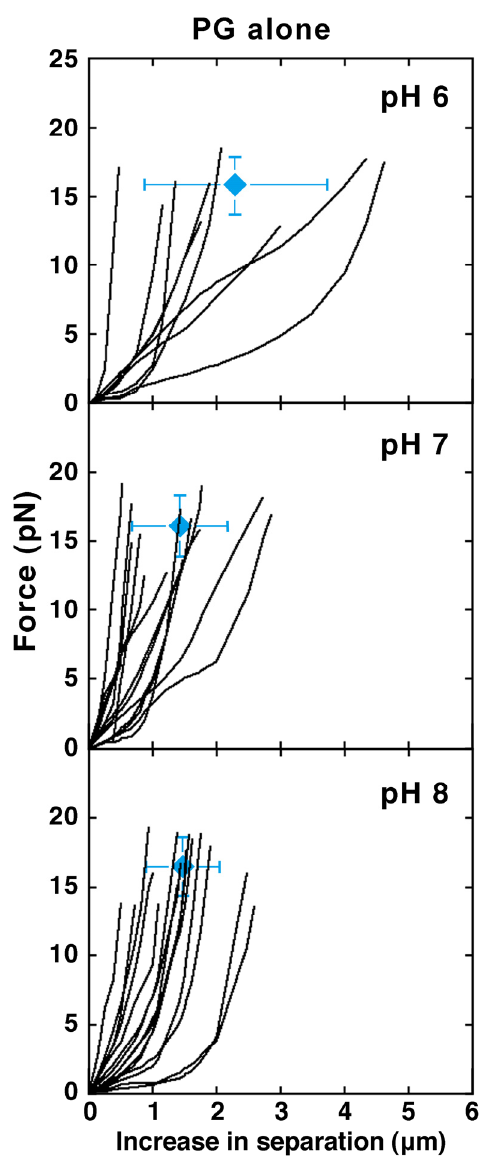
Figure 4. Liposomes made from PG alone under different pH conditions. Top, middle and bottom show the results for pH 6, 7 and 8, respectively. In each panel, the average and S.D. of the ending positions of plots is indicated (N is 9 (pH 6), 13 (pH 7) and 15 (pH 8)). The numerical of the average and S.D. is shown in Supplemental Table S2. HEPES-buffer (5 mM HEPES-NaOH, pH 7.0), HEPES (pH 8.0)-buffer (5 mM HEPES-NaOH, pH 8.0) or MES-buffer (5 mM MES-NaOH, pH 6.0) were used for swelling the lipid films to